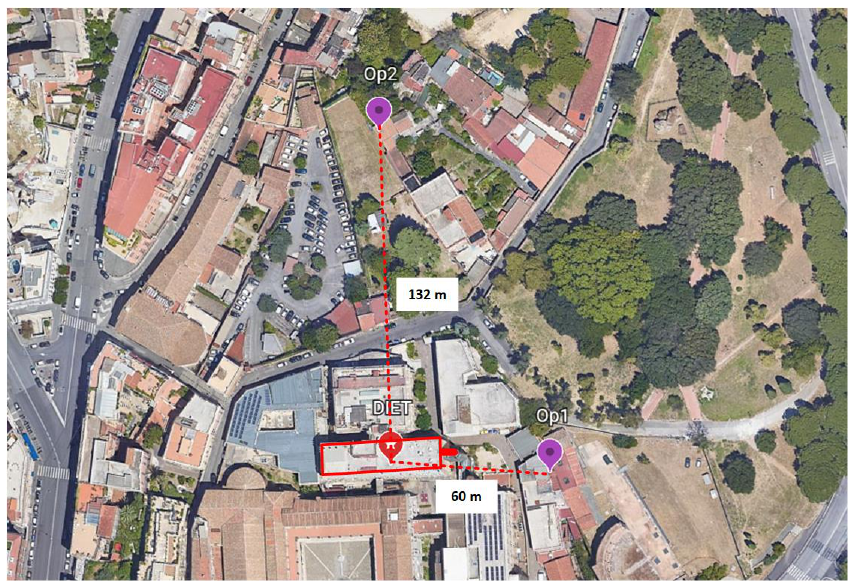
Figure 2. Google Earth map showing the DIET Department and the estimated position of the PCIs for Op1 and Op2 detected with highest